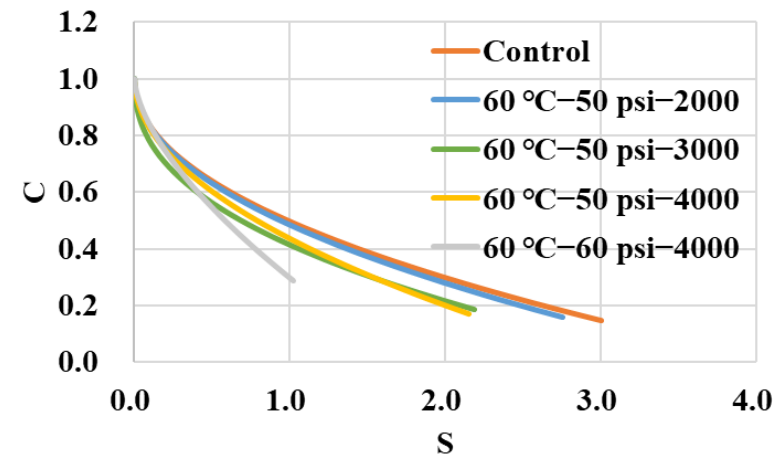
Figure 9. Damage characteristic curves of asphalt binder in LAS tests.